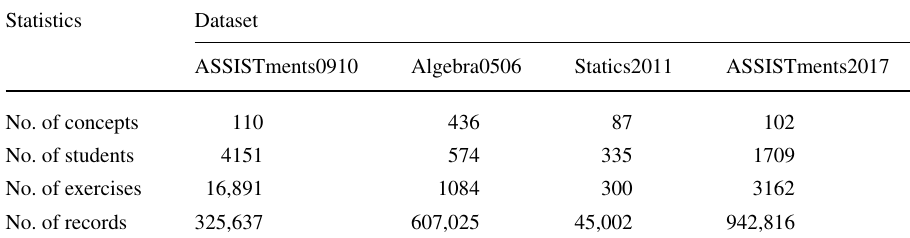
Table 1 Summary of